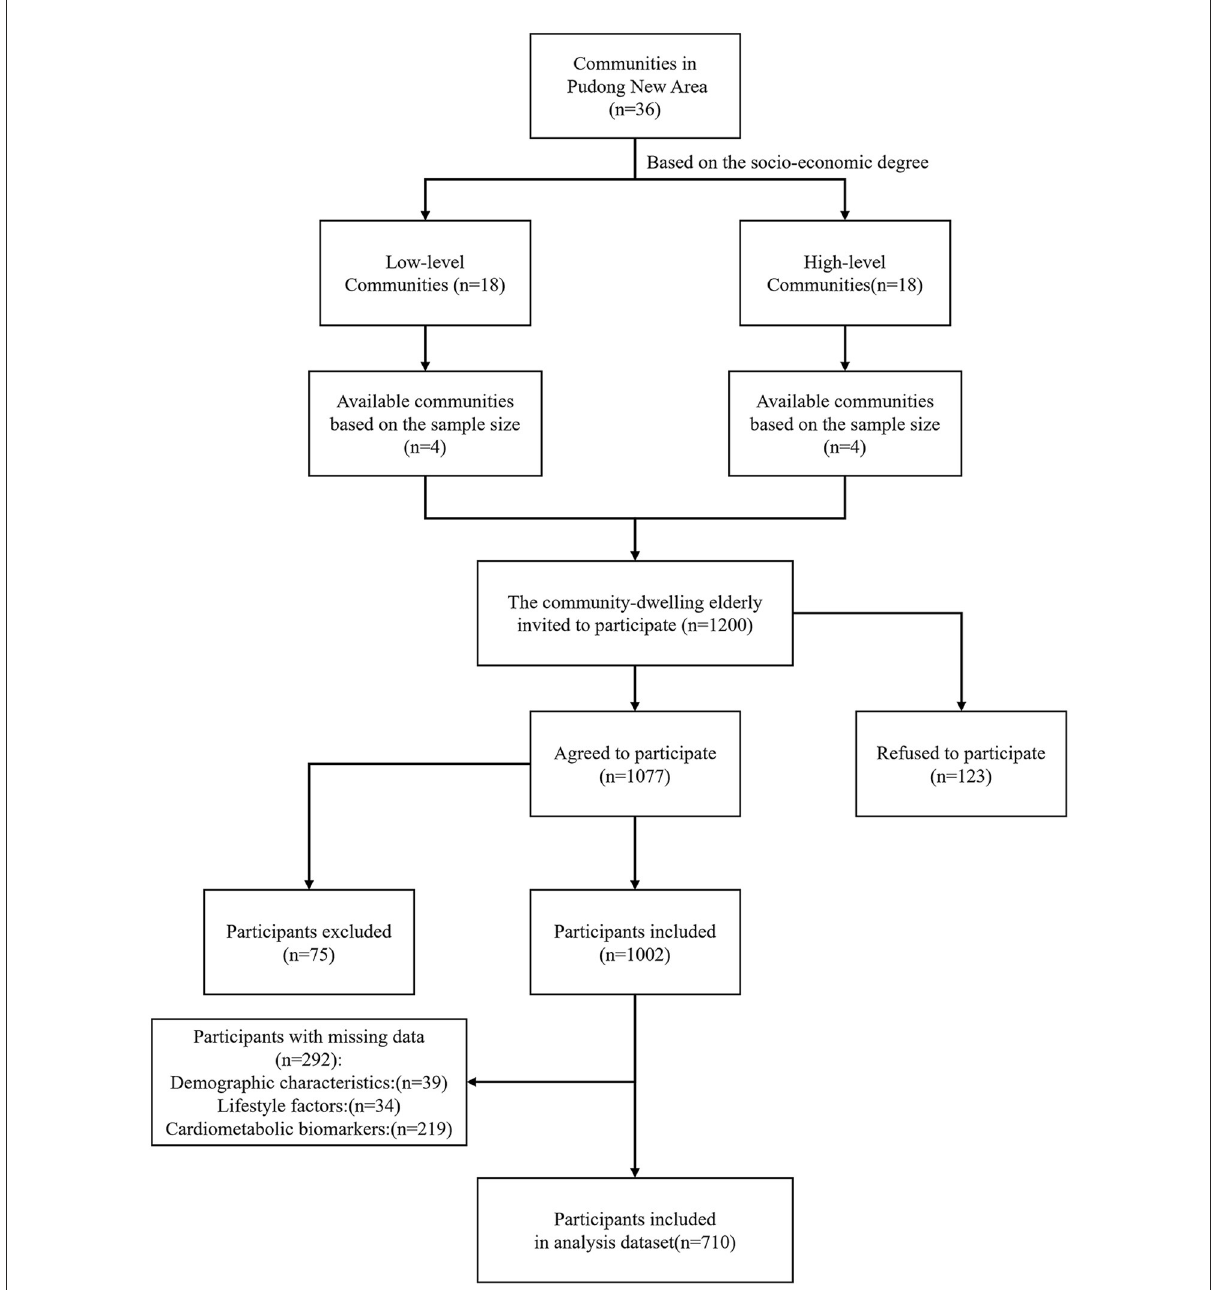
FIGURE1 Flowchart of participants included in the secondary